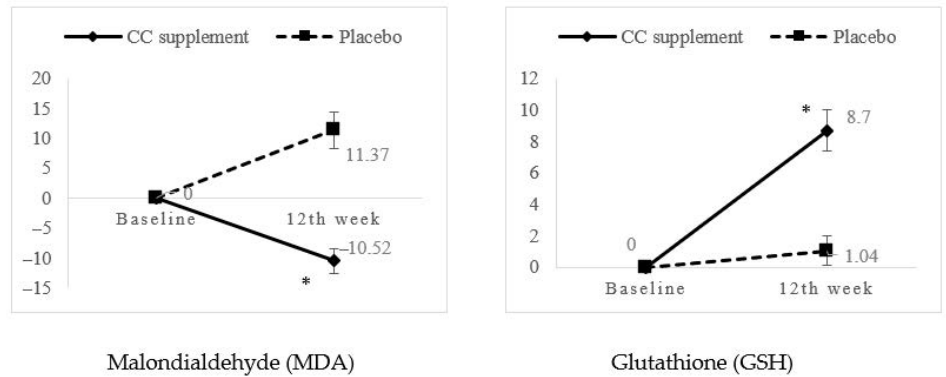
Figure 3. Percentage mean change of significant biomarkers from baseline to 6th week and 12th week follow-ups. * Significant at p < 0.05 using independent t -test.